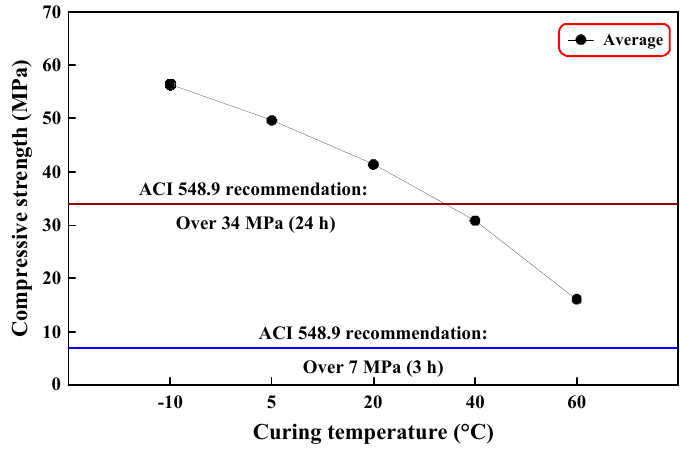
Figure 5. Effect of curing temperature on average compressive strength.